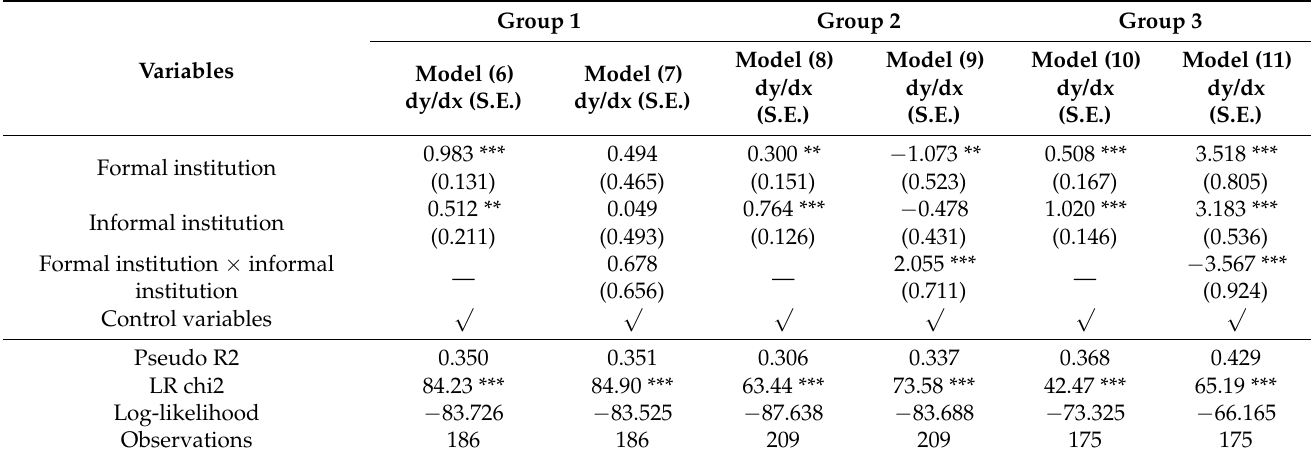
Table 5. Results of the effect of formal and informal institution on farmers’ behavior to WRH under different